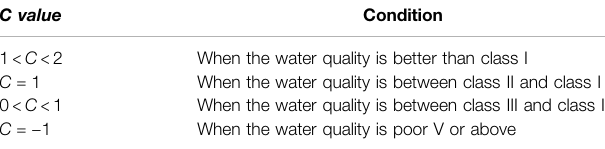
TABLE 5 | The rule of water quality adjustment coef fi cient